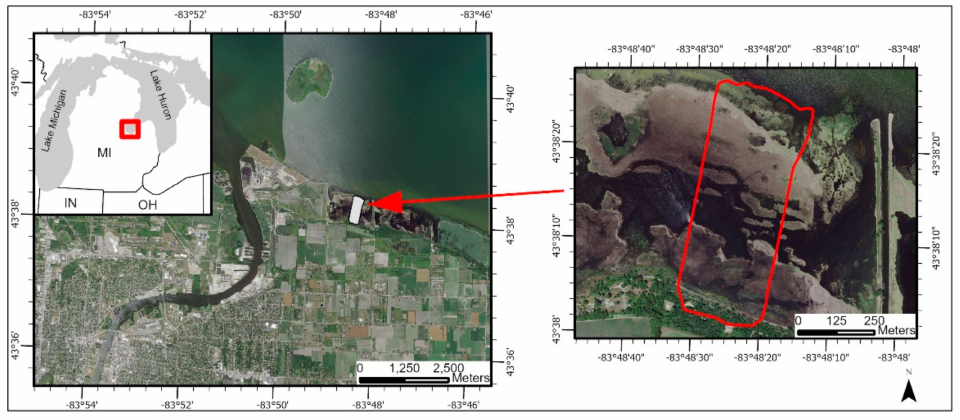
Figure 2. Study site located in Saginaw Bay, Michigan, USA. Grassy Point Park (Figure 1B) is a 71-acre wetland complex located in Duluth, Min- nesota along the St. Louis River. Grassy Point Park, located roughly four miles from Lake Superior, is the point where Keene Creek meets the St. Louis River. Grassy Point is heavily influenced by industrial land use. The park was the site of sawmilling operations that dumped wood waste into the estuary during the 19th century [50]. Currently, the complex is bordered by a railroad line, shipping channel, and a coal dock. Grassy Point has six different plant communities within the basin, including: seasonally flooded basin, shallow marsh, deep marsh, shallow open water, shrub swamp, and wooded swamp. Within this basin there are known patches of Phragmites , Typha spp. (cattails), Alnus spp. (alder), and other woody vegetation. Typha spp. is the most dominant vegetation